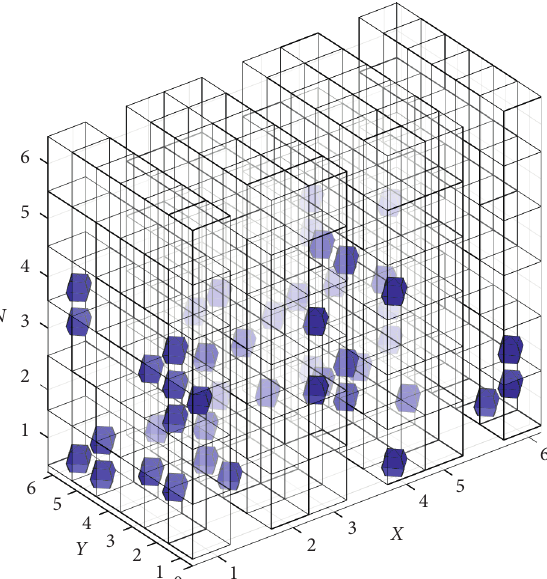
Figure 1: The stereogram of a